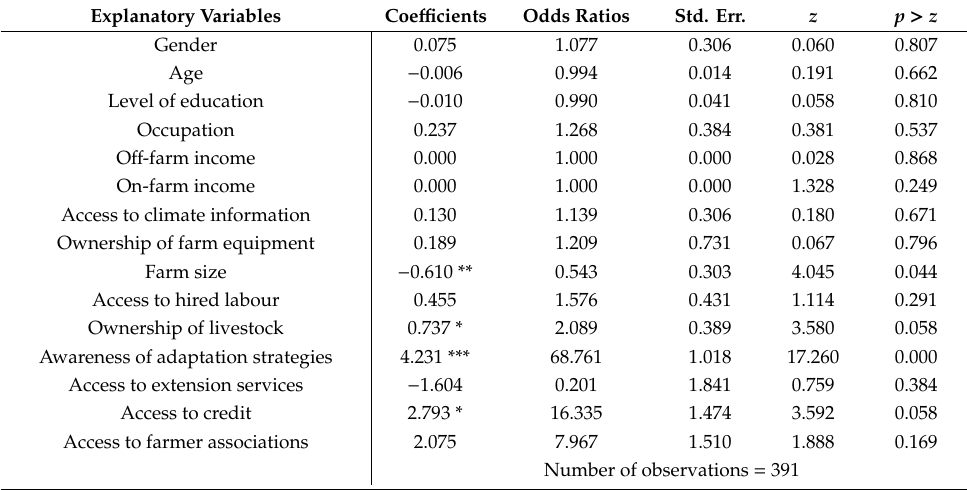
Table 7. Estimated results on the factors influencing the adoption of scientific adaptation